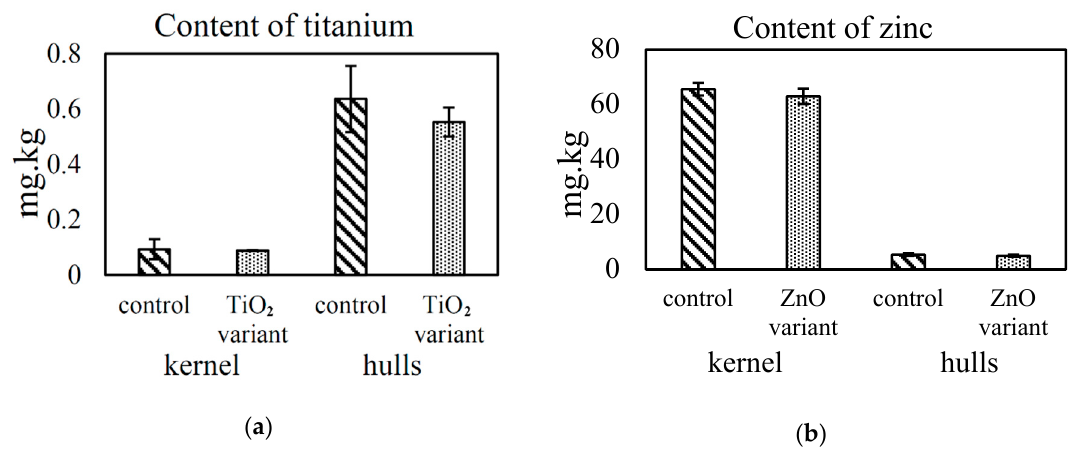
Figure 5. Comparison of total titanium ( a ) and zinc ( b ) concentrations in the kernel and hulls of fully-ripe sunflower seeds after foliar application of titanium dioxide, zinc oxide nanoparticle variants and the control.